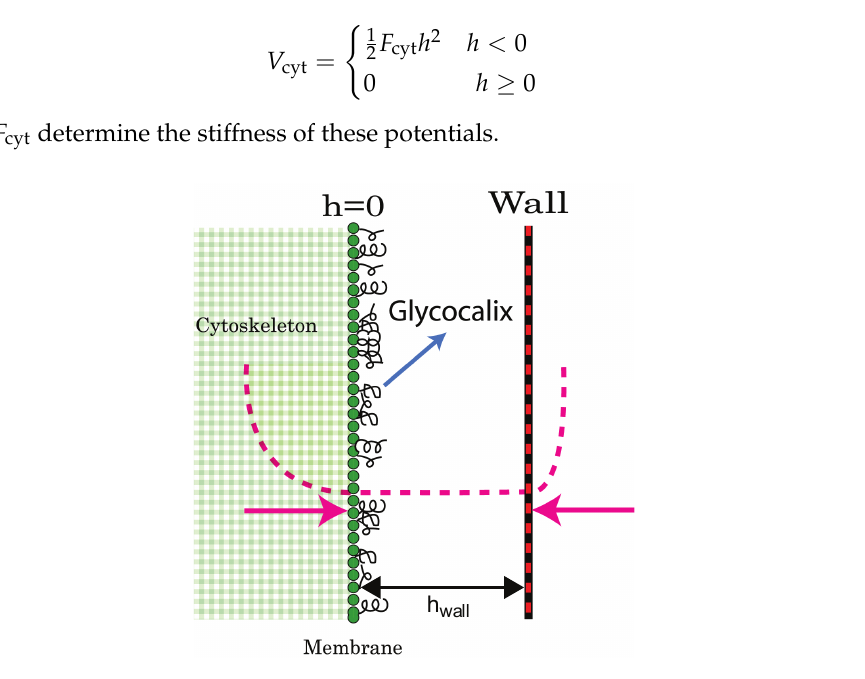
Figure 8. Illustration of the model. The substrate (“wall”) acts as a spring with a force F wall ( h − h wall ) (right pink arrow) when the membrane height h exceeds the boundary location h wall . The cytoskeleton acts in the same way only in the opposite direction (left pink arrow) and is typically softer, i.e., F cyt < F wall